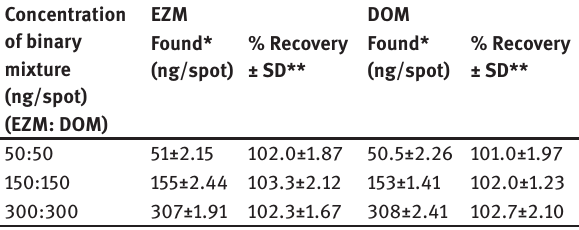
Table 6: Determination of ESO and DOMP in human Figure 5: TLC of unspiked plasma (A) and spiked plasma (B). Figure 5: TLC of unspiked plasma (A) and spiked plasma (B).